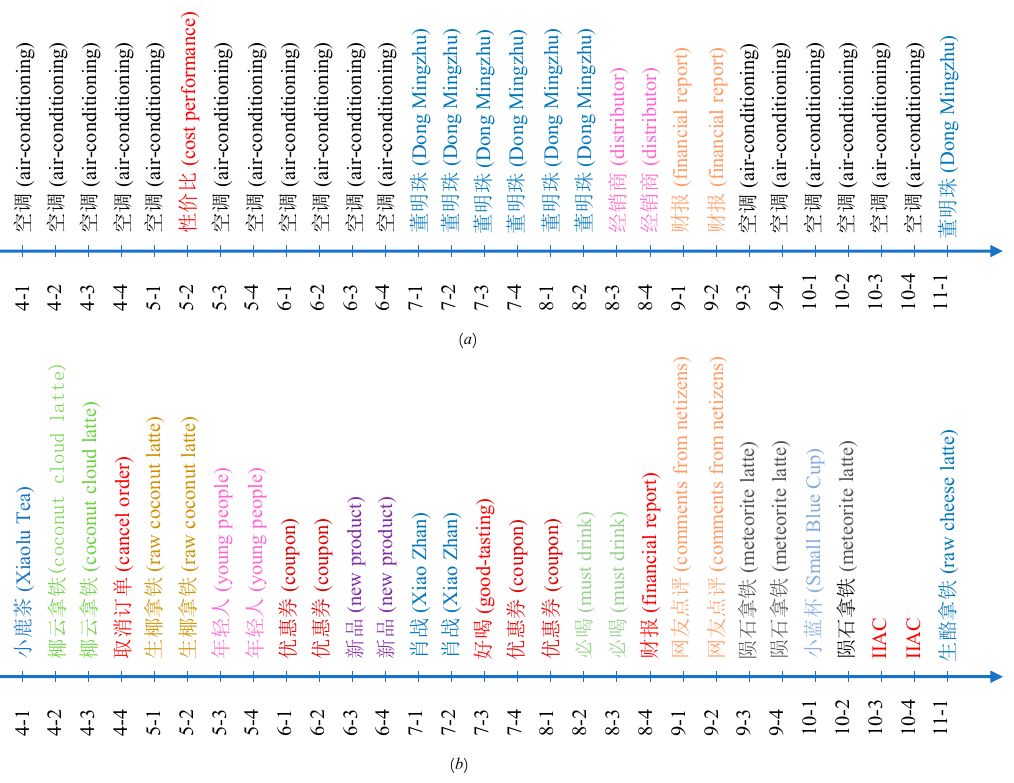
Figure 11. The Timelines of the Second Most Frequent Words Weekly. ( a ) the Timeline of GREE Electric. ( b ) the Timeline of Luckin Coffee. The words in the brackets next to each Chinese word are its meaning notes in English.